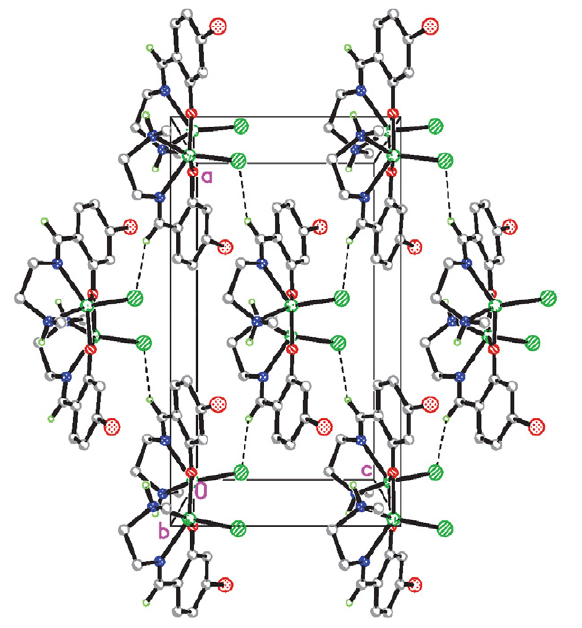
Fig. 3. Molecular packing diagram of complex 1 , viewed along the b axis. Hydrogen bonds are drawn as dashed lines.